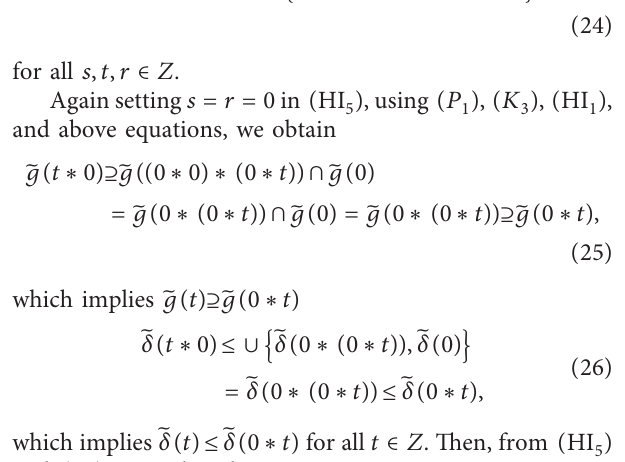
Table 10: Table representation of hybrid structure 􏽥 g